Question: Condense the content of this figure into a single sentence.
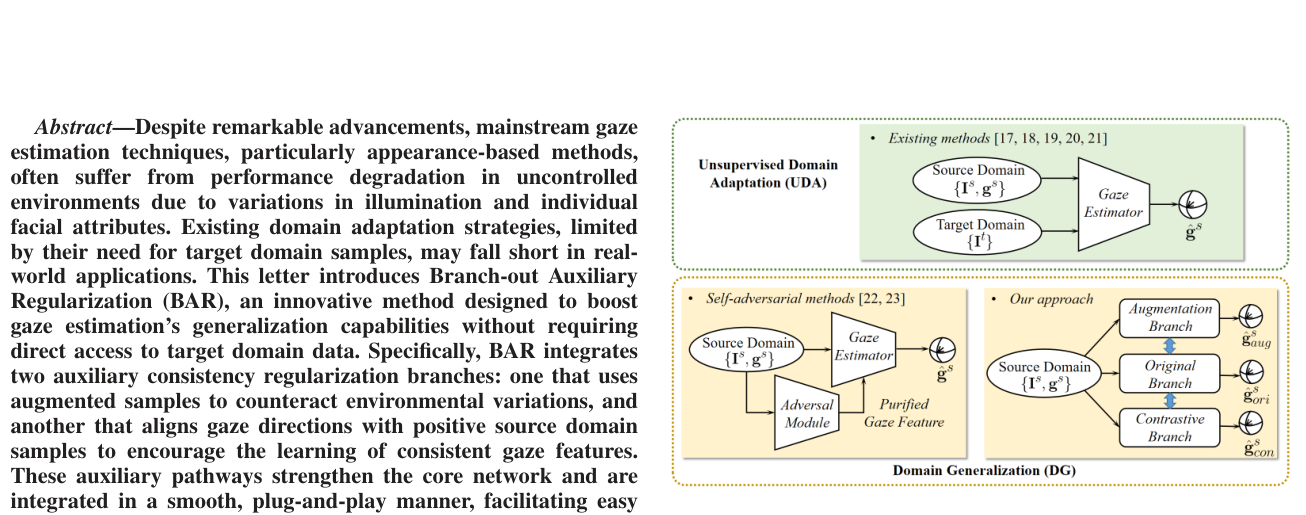
Answer: Comparison of our method with conventional UDA and DG methods for gaze estimation. UDA methods generally rely on target domain data to enable knowledge transfer from the source domain to the target domain. Con- ventional DG methods leverage uncontrolled adversarial learning techniques that may cause feature elimination problems. Our method, in contrast, requires no access to target domain data and leverages flexible auxiliary consistency regularization branches to enhance model generalization.